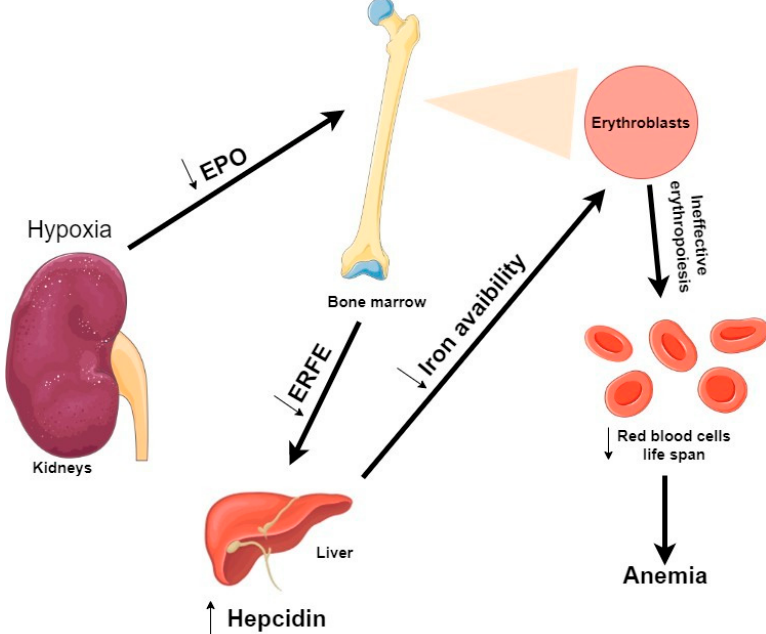
Figure 5. Overview of erythropoiesis regulation in uremic condition. During hypoxia and in a CKD condition, accumulation of uremic toxins by the kidneys leads to a decrease of EPO production. During erythropoiesis, because erythroblasts are less produced, ERFE production is decreased. As ERFE is the regulator of hepcidin, a decrease of ERFE production leads to an increase of hepcidin. Thus, leading to a decrease of iron availability. As a consequence, many erythroblasts incur apoptosis before completing differentiation, causing an ineffective erythropoiesis and fewer red blood cells are produced. Abbreviations: EPO, erythropoietin; ERFE, Erythroferrone.